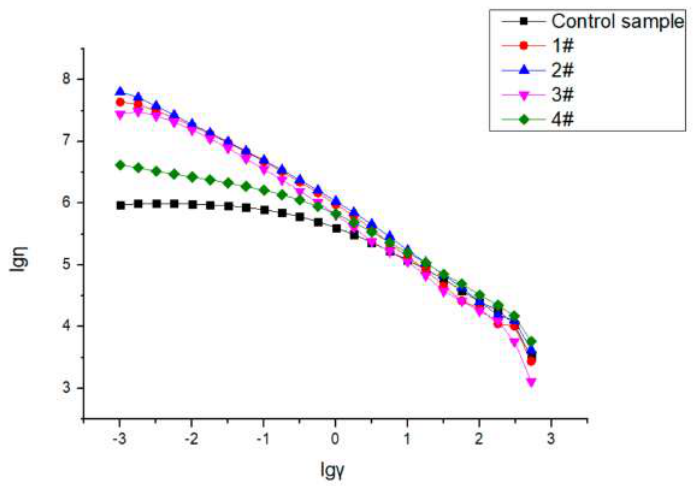
Figure 1. Comparison of steady-state rheological curves.